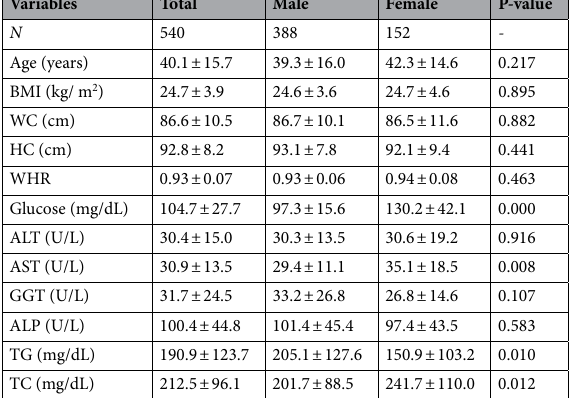
Table 1. Baseline characteristics of participants. Data are presented as mean ± SD. P-values are obtained from the independent sample t-test in comparison between male–female